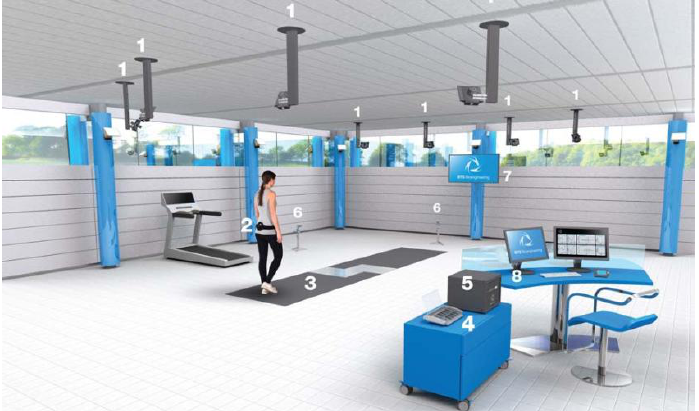
Figure 11. Example of NWS system: BTS GaitLab configuration. ( 1 ) infrared videocameras; ( 2 ) inertial sensor; ( 3 ) GRF measurement walkway; ( 4 ) wireless EMG; ( 5 ) workstation; ( 6 ) video recording system; ( 7 ) TV screen; ( 8 ) control station. Reproduced with permission from BTS Bioingenieering.